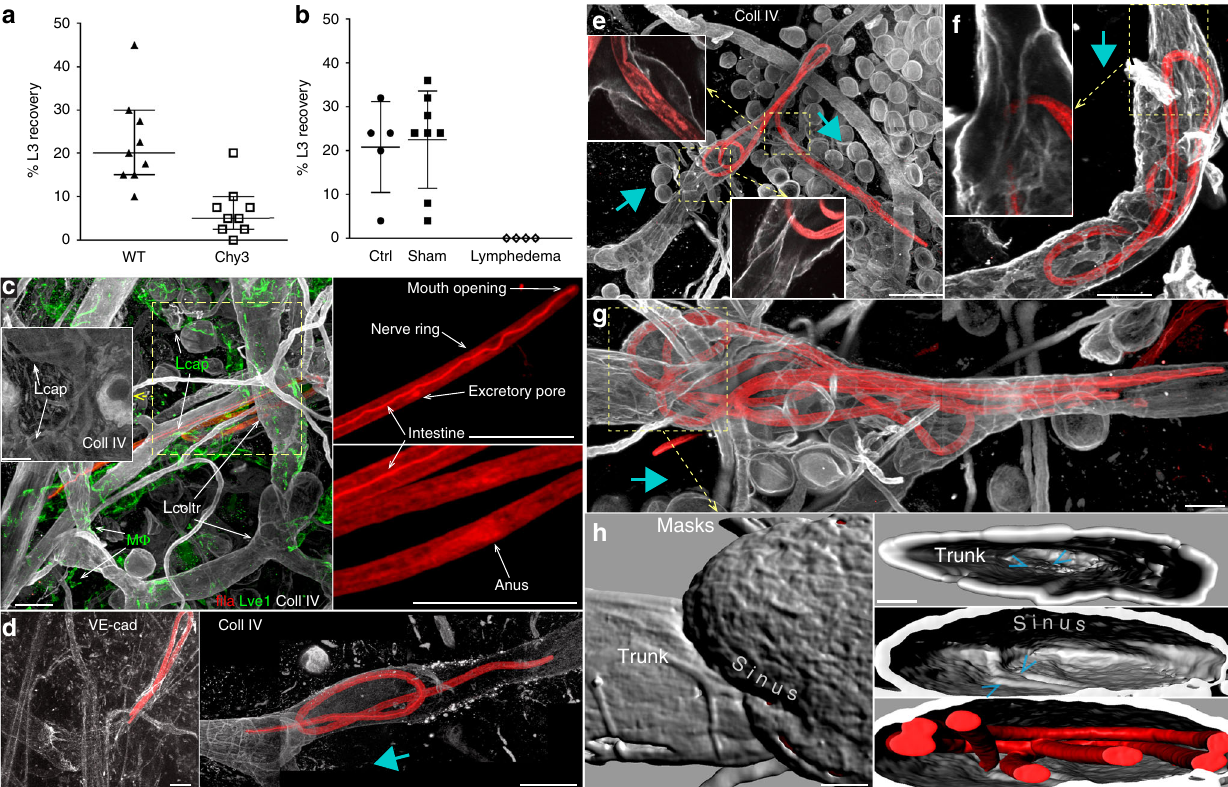
Fig. 1 Lymphatic valves direct migration of fi laria larvae toward the lymph node. a Model of primary lymphedema. Success rate for L. sigmodontis fi lariae migration to the pleural cavity (as % inoculated 10 days earlier) after inoculation in lymphedematous hind paw of Chy3 mice. Totally, 40 fi lariae were injected in each of 9 control and Chy3 mice ( p = 0.0003, one-tailed Mann – Whitney U test). b Model of secondary lymphedema. Success rate for L. sigmodontis fi lariae migration to the pleural cavity after inoculation into lymphedematous tails. Totally, 40 fi lariae were injected in 6 (control), 8 (sham), and 4 (lymphedema; p = 0.00021, two-tailed Fisher exact test (3 × 2 table). For a , b , individual results (with means and standard deviations) of two pooled experiments are shown. Source data are provided as a Source Data fi le. c – h Maximum intensity projections (MIP) of immunostained whole-mounted dorsal ear dermis with migrating fi lariae. c Left, TRITC-labeled fi lariae ( fi la) outside the Lyve1 (Lve1)-stained lymphatics capillaries (L cap ) and collagen IV (Coll IV)- stained collectors (L coltr ). M φ -macrophages. Inset. One micrometre optical section shows basement membrane of capillary lymphatic. Right, fl uorescent labeling of a larva revealed the presence of anatomical organs and allowed identi fi cation of its head-to-tail orientation (Supplementary Note 3). d – h Intravascular larvae were found only in lymphatic precollectors. d Left, In contrast to blood vessels, lymphatic precollectors are weakly stained with VE- cadherin (VE-cad). d Right, Strong signal from collagen IV revealed the characteristic morphology of lymphatic collectors. The larva that is crossing the valve is located at the trunk-side of the lymphatic valve. e – h Valves of lymphatic collectors prevent afferent fi lariae migration. e , f Insets. Directionality of lymphatic valves on 1.8 µ m optical cross-sections. g Three larvae coiled at the post-valve sinus. h The structure of the valve. Surface masks created from the MIP image shown in ( g ). Migrating larvae have a higher probability of localizing the inlet of the lymphatic trunk than the outlet of the lymphatic sinus because the valve opening occupies a proportionally larger area of the smaller prevalve lymphatic trunk. Blue arrows in ( d – g ) indicate the original directionality of lymphatic drainage. Blue arrowheads in ( h , right) point to the edges of the valve in the trunk (top) and the sinus (middle). Bars = 50 µ